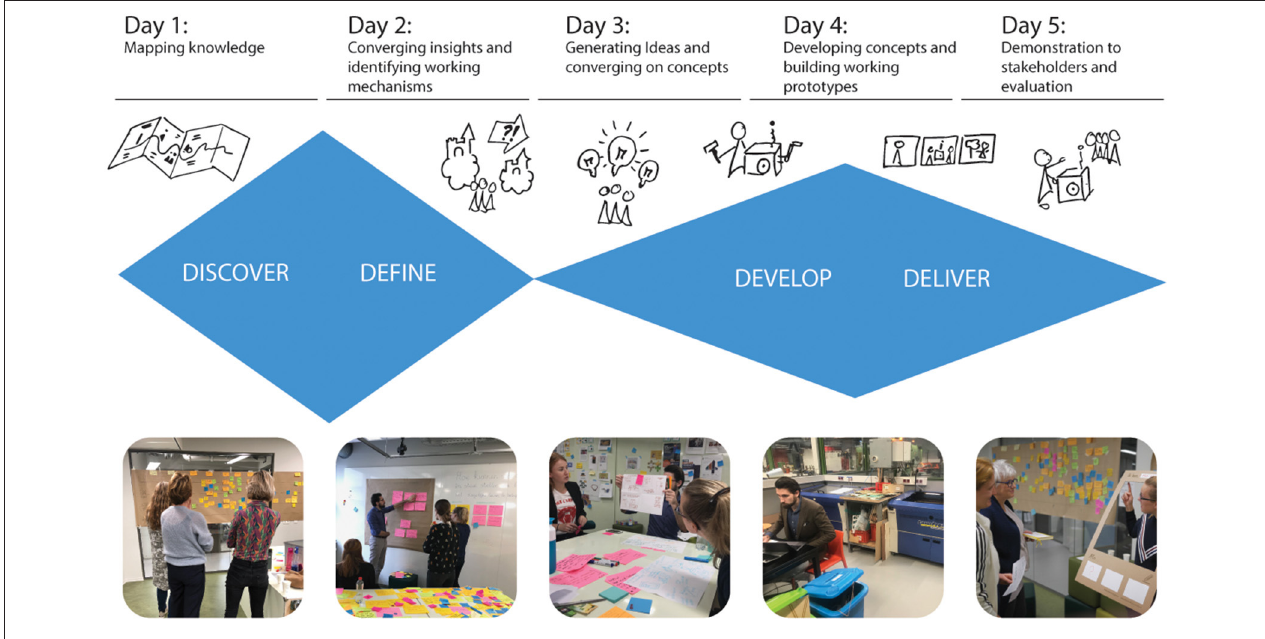
FIGURE 2 | A visual representation of a 5 day sprint